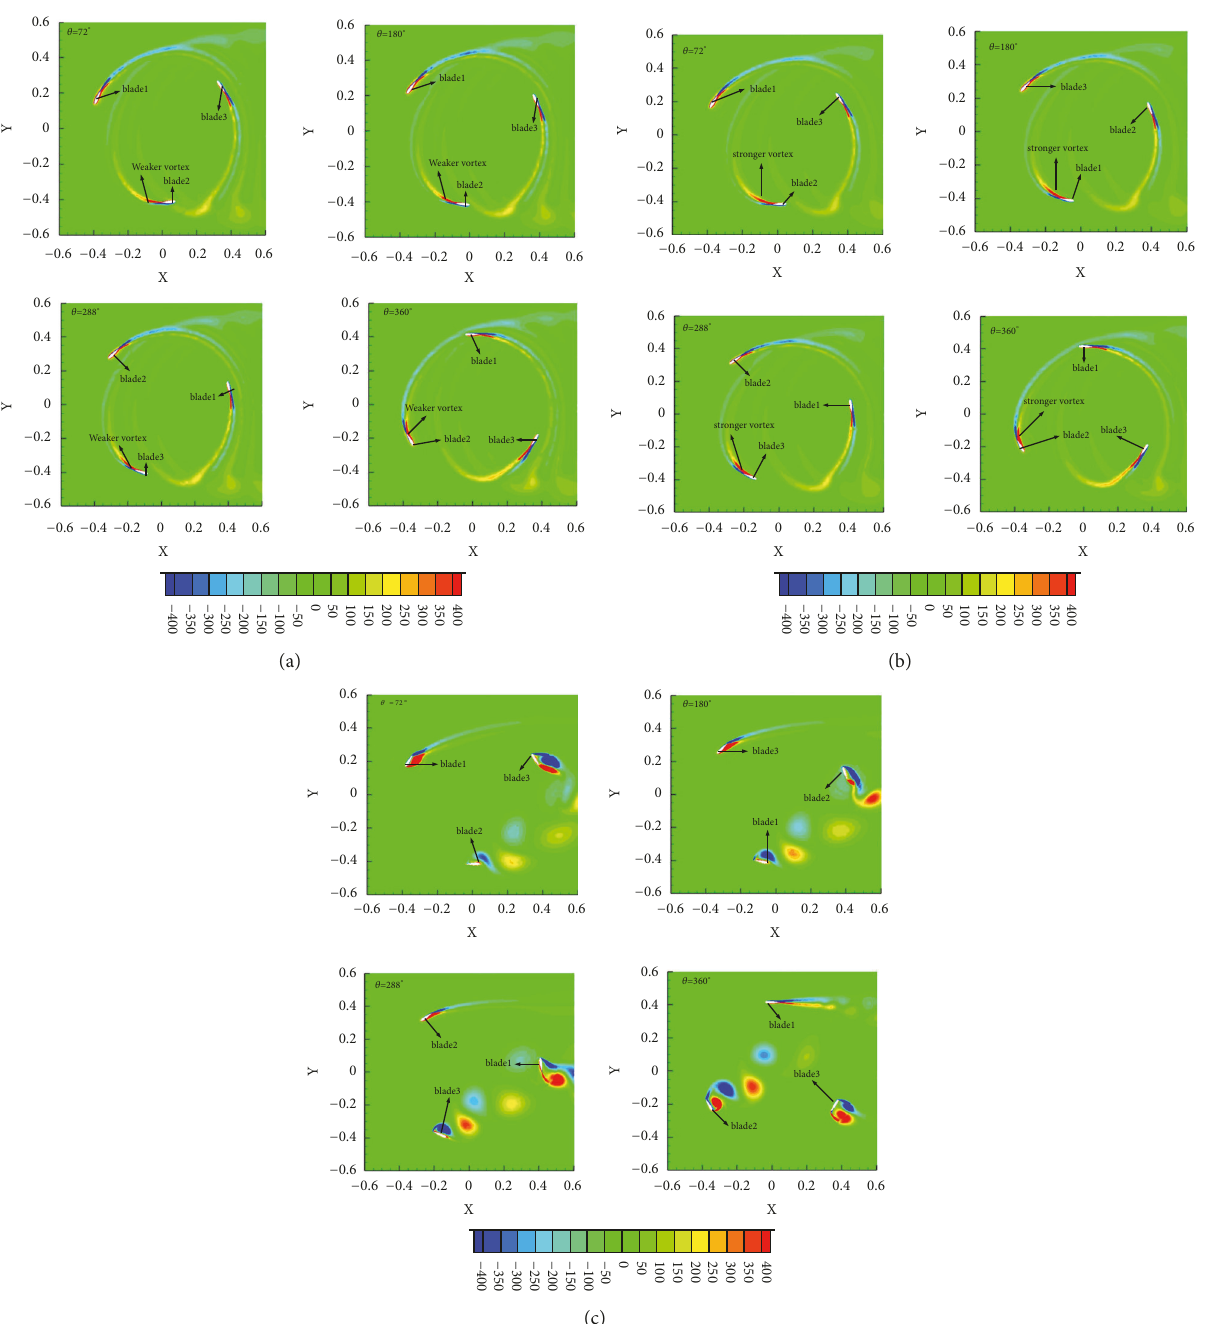
Figure 8: The vortices contours of the three specific H-VAWT 𝜓 at Re = 6.82 × 10 5 (a) 𝜓 =0.05 (b) 𝜓 =0.80 (c) 𝜓 =1.00.